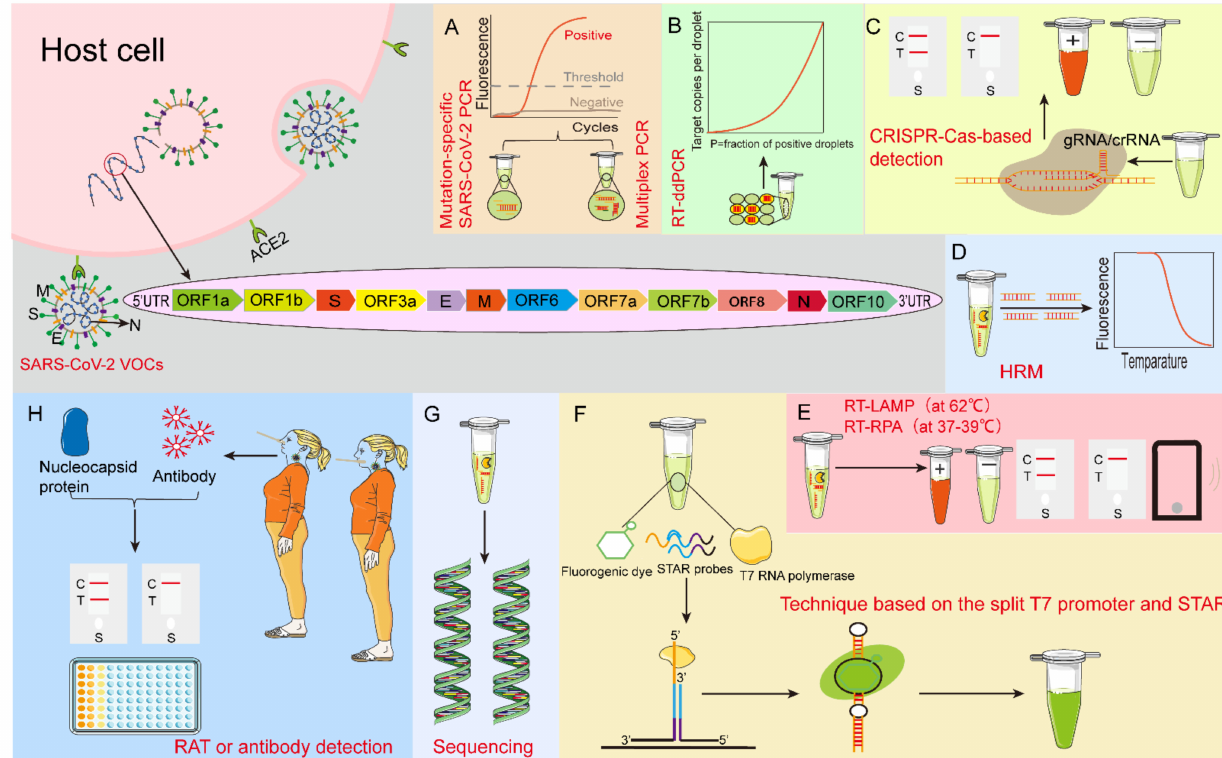
Figure 1. Schematic of nucleotide and protein detection methods for SARS-CoV-2 VOCs. ( A ) Mutation- specific SARS-CoV-2 PCR and multiplex PCR. ( B ) RT-ddPCR: droplet digital reverse transcription- quantitative polymerase chain reaction. ( C ) CRISPR-Cas-based detection technology: Clustered Regularly Interspaced Short Palindromic Repeats-CRISPR-associated proteins-based detection technology. ( D ) HRM: high − resolution melting. ( E ) RT-LAMP: reverse transcription loop-mediated isothermal amplification assay (at 62 ◦ C) and RT-RPA: reverse transcription-recombinase polymerase amplification (at 37–39 ◦ C). ( F ) Technique based on the split T7 promoter and luminescent RNA aptamer (STAR). ( G ) Sequencing. ( H ) RAT: rapid antigen test, and antibody detection. ACE2: angiotensin-converting enzyme